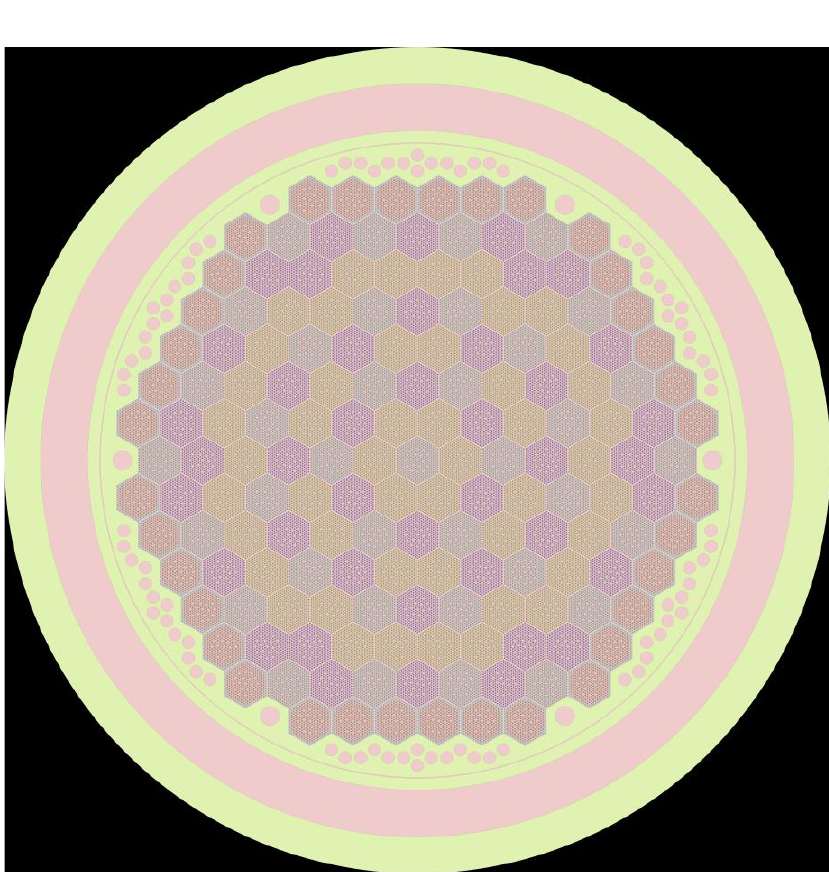
Figure 3: VVER-1000 SERPENT model, top